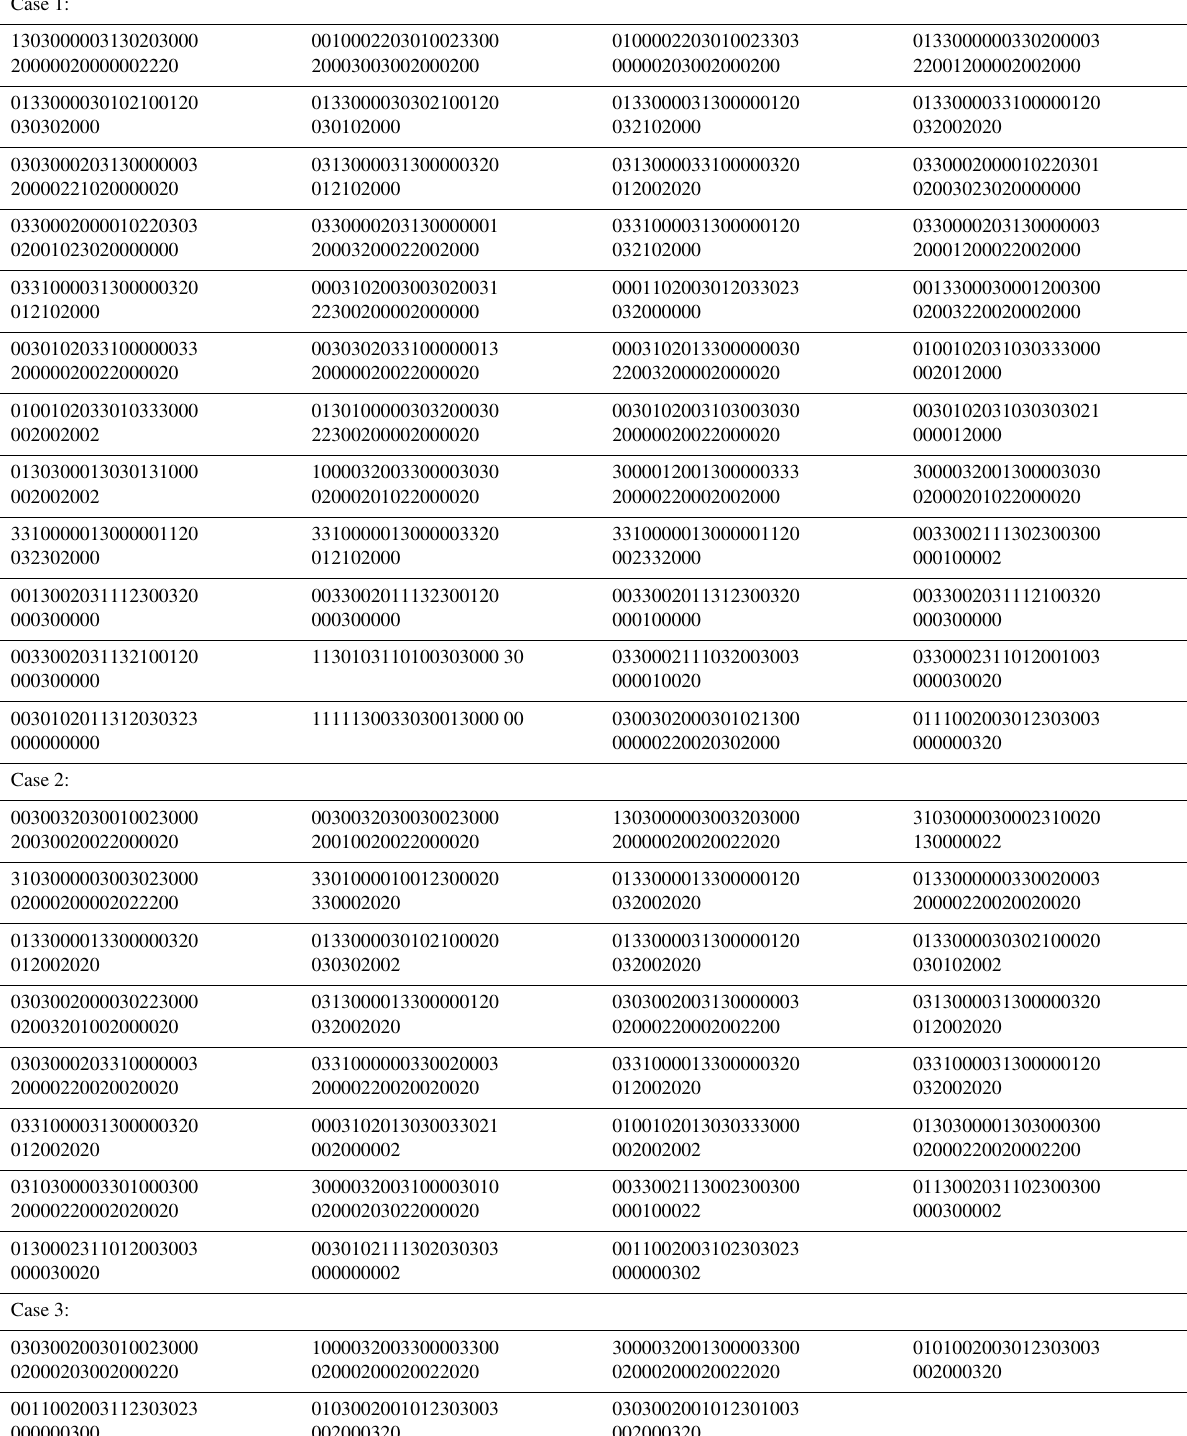
Table D1. The complete database of 1 DOF seven-bar